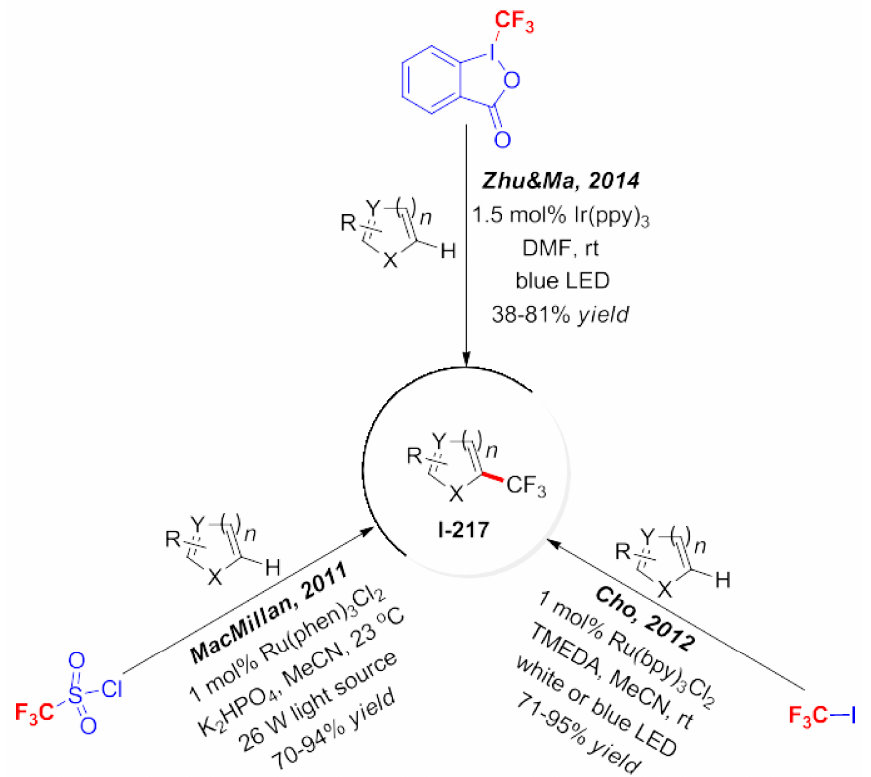
Scheme 58. Photocatalytic trifluoromethylation of aromatic rings.